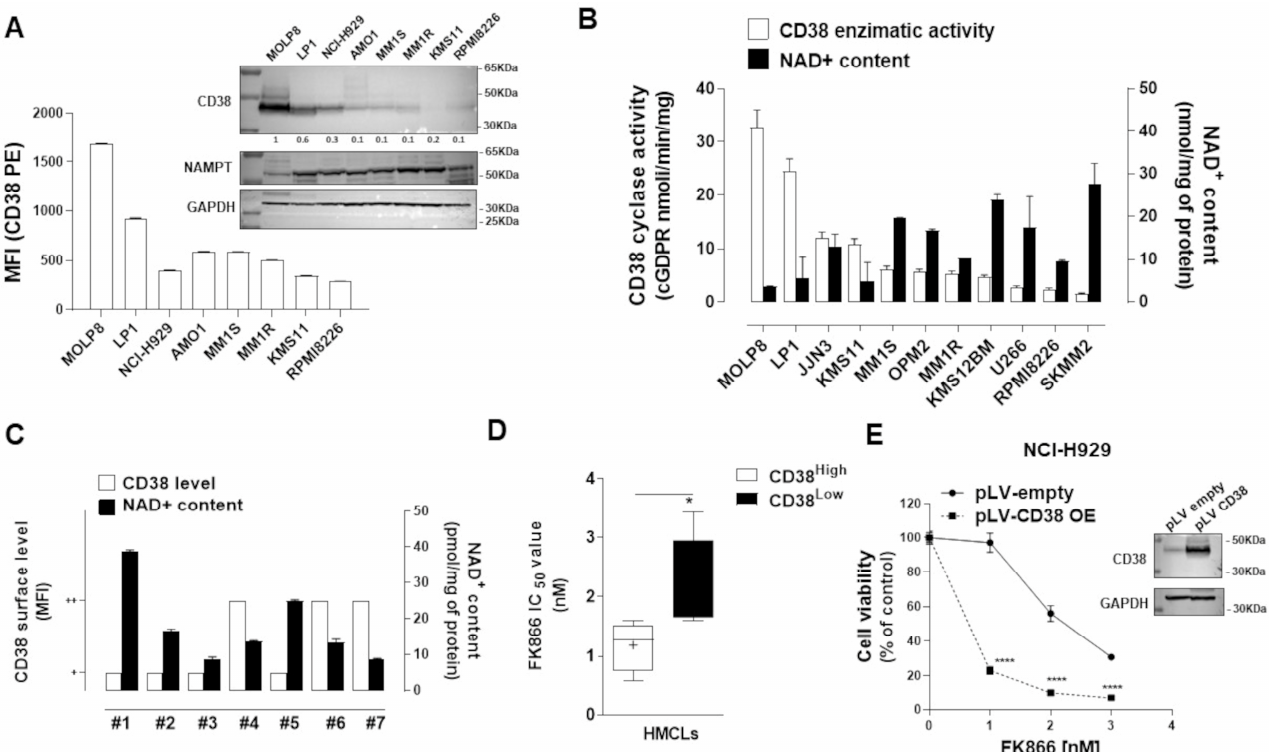
Figure 1. CD38 enzymatic activity affects NAD + intracellular level and influences anti-MM activity of NAD + -depleting agents. ( A ) A panel of MM cell lines (HMCLs) were analyzed for CD38 and NAMPT protein levels by WB ( top panel ) or quantitative flow cytometry ( bottom panel ). One representative experiment is shown. ( B ) NAD + content and CD38 enzymatic activity (GDP-ribosyl cyclase) were measured in indicated HMCLs. ( C ) NAD + content and CD38 surface level (based on arbitrary units, as detailed in the Supplementary Materials) were measured in CD138+ cells derived from MM patients. ( D ) Relative expression of CD38 surface protein plotted versus FK866 cytotoxicity IC 50 values: box plot showing cumulative results of MTS assays. ( E ) H929 cell line was lentivirally transduced with empty pLV and CD38-overexpressing pLV (CD38 OE) and then treated with increasing doses of FK866 (0–10 nM) for 96 h. Cell viability was measured with an MTS assay and presented as a percentage of control. Data are presented as mean ± S.D ( n = 3) (* p ≤ 0.05, **** p ≤ 0.0001; unpaired t